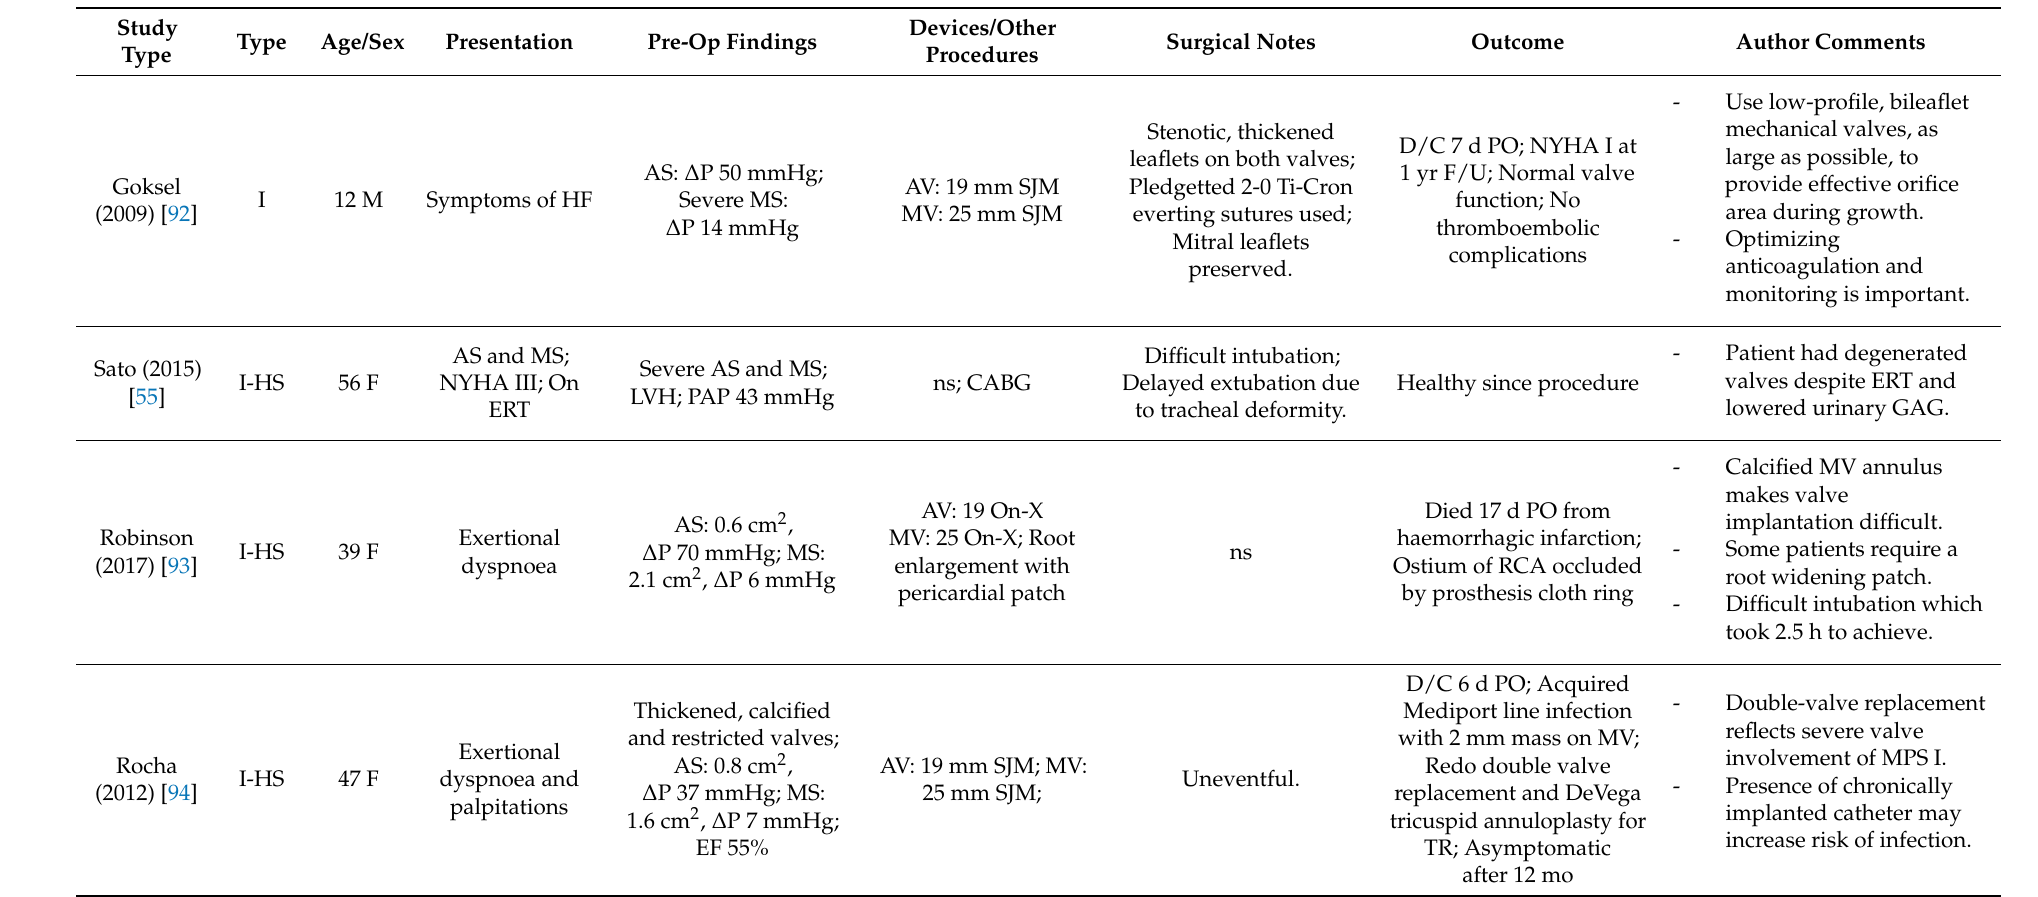
Table A2. Description of case reports of double valve